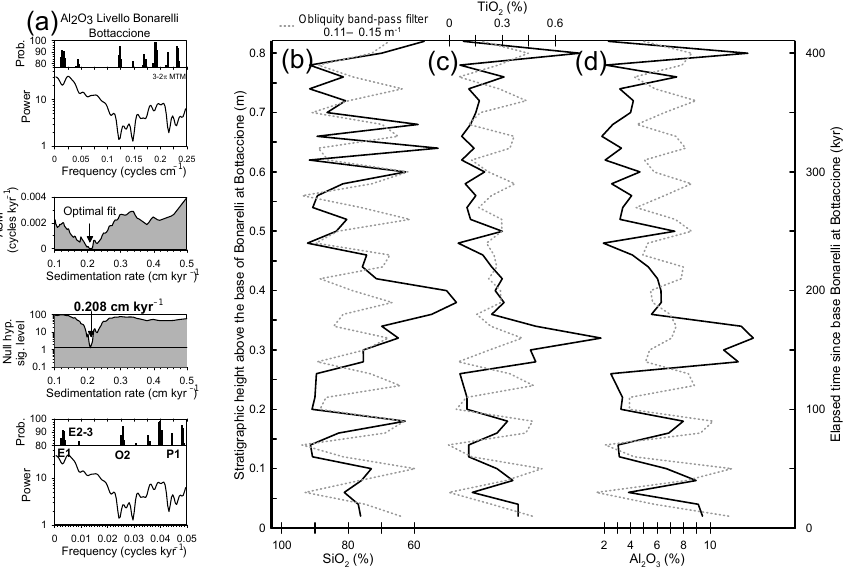
Figure 5. (a) Duration estimate of Livello Bonarelli at Bottaccione based on the average spectral misfit (ASM) method. (b–d) SiO 2 , TiO 2 and Al 2 O 3 data show ∼ 8cm thick cycles, interpreted as obliquity. The duration of the Livello Bonarelli at Bottaccione is estimated at